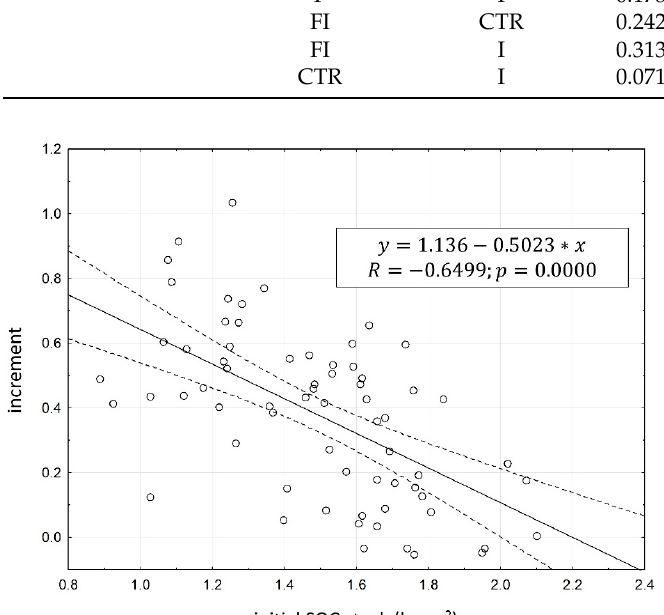
Figure 2. Relationship between increment (difference between the SOC stock measured after 6 years of SRC and that at the starting point at the same locations) and initial SOC stock (H-SRC and VH-SRC considered together) and its 95% confidence interval.